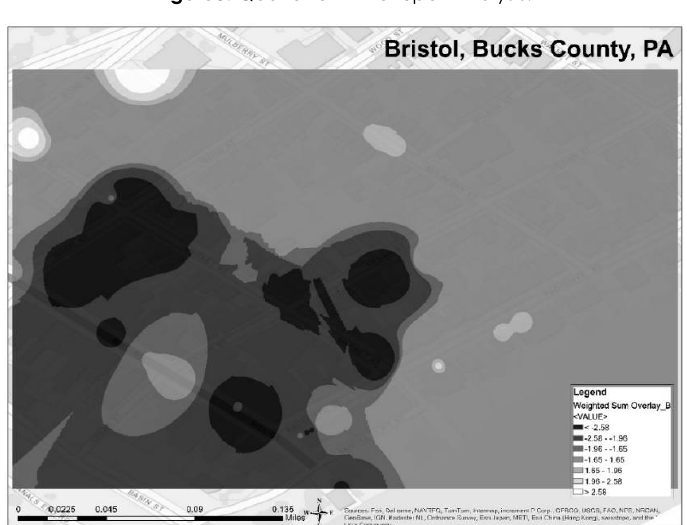
Figure3 . Quakertown Hot Spot Analysis.